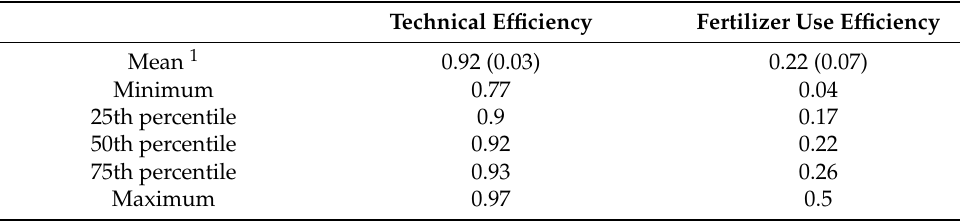
Table 1. Technical efficiency and fertilizer use efficiency scores.